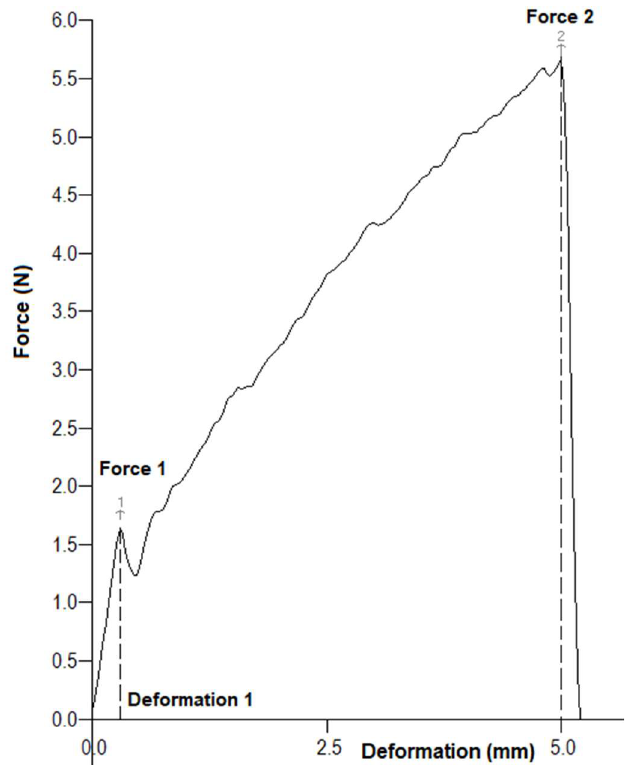
Figure 2. The force–deformation curve of an acorn: Force 1 and Deformation 1—force and deformation of material at the moment of penetration of the shell, Force 2—force recorded at deformation of 5 mm.